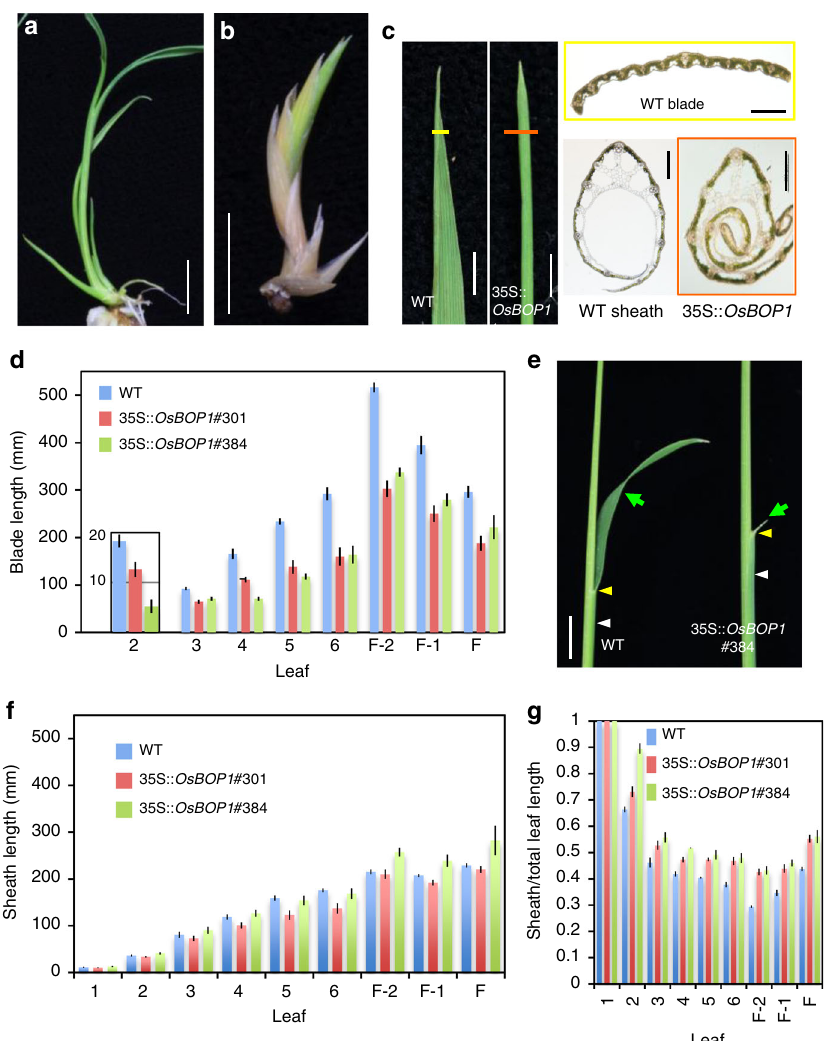
Fig. 6 Effects of constitutive overexpression of OsBOP1 ( a , b ) non-transformed ( a ) and 35s:: OsBOP1 ( b ) plantlets. c The tip of leaves in the WT and in 35s:: OsBOP1 with severe effects. Cross-sections at regions indicated with yellow and orange bars are shown in yellow and organ squares right to the panels, respectively (Bars indicate 200 μ m). d The average length of leaf blade. ‘ F ’ indicates the fl ag leaf, which is the last leaf. The blade length in the second leaf is shown at one-tenth the scale in the y -axis. The blade length in both 35s:: OsBOP1 lines shown in d is shorter than that in the WT (Dunnett ’ s test, P < 0.05). e View of WT and 35s:: OsBOP1 #384 seedlings. Green arrows, yellow arrowheads and white arrowheads indicate the leaf blade, blade/sheath boundary and leaf sheath, respectively, in the second leaf. f , g The average length of leaf sheath ( f ) and the ratio of sheath/total leaf length ( g ). The ratio of sheath/total leaf length in both 35s:: OsBOP1 lines is higher than that of the WT with the exception of the fi rst leaf in #384 and the fi rst to third leaves in #301 (Dunnett ’ s test, P < 0.05). The length of the leaf sheath in both 35s:: OsBOP1 lines is not statistically different from that of the WT with the exception of the fi fth and sixth leaves in #301 and of the F-2 and F-1 leaves in #384 (Dunnett ’ s test, P < 0.05). h – j The leaf blades in 35 s:: OsBOP1 # 384. Error bars indicate standard error ( n = 6 biologically independent samples for WT; n = 5 biologically independent samples for #301 and #384,). Bars: 1 cm ( a , b , d ), 3 mm ( c , e ). Source data of Fig. 6d, f, and g are provided as a Source Data fi